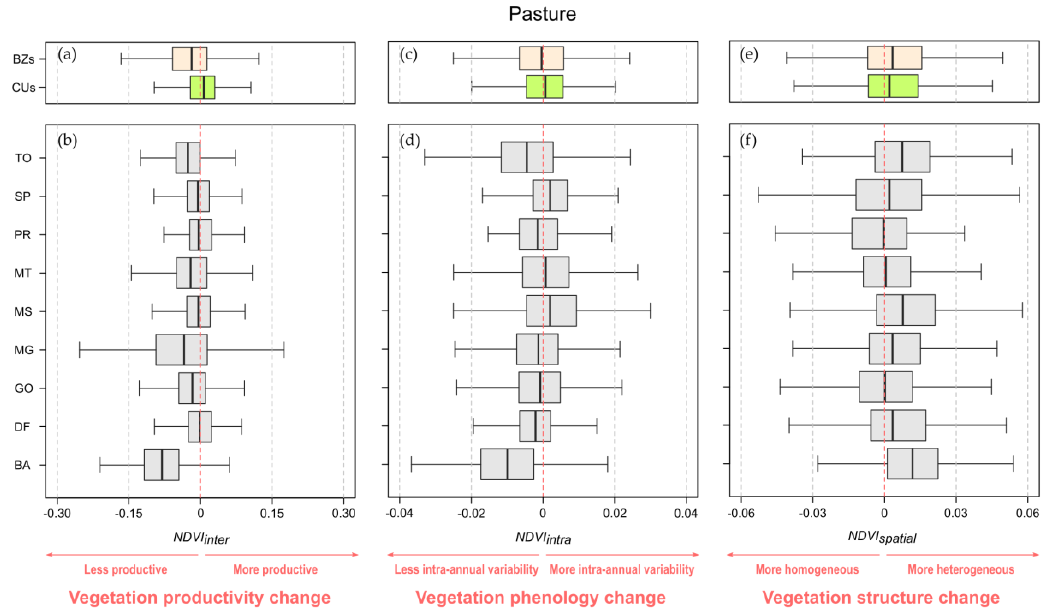
Figure E2. Boxplots of the landscape metrics’ values of the cells belonging to the ‘Pasture’ category : ( a ) 𝑁𝐷𝑉𝐼 𝑖𝑛𝑡𝑒𝑟 in the buffer zones (BZs) and conservation units (CUs); ( b ) 𝑁𝐷𝑉𝐼 𝑖𝑛𝑡𝑒𝑟 in each state; ( c ) 𝑁𝐷𝑉𝐼 𝑖𝑛𝑡𝑟𝑎 in the BZs and CUs; ( d ) 𝑁𝐷𝑉𝐼 𝑖𝑛𝑡𝑟𝑎 in each state; (e) 𝑁𝐷𝑉𝐼 𝑠𝑝𝑎𝑡𝑖𝑎𝑙 in the BZs and CUs; ( f ) 𝑁𝐷𝑉𝐼 𝑠𝑝𝑎𝑡𝑖𝑎𝑙 in each state. Number of 250 m resolution (6.25 ha) cells located inside the 61 conservation units = 1319 and in their buffer zones = 34,832. Number of cells in each Brazilian state with n > 0: Tocantins (TO, 436), São Paulo (SP, 3147), Paraná (PR, 45), Mato Grosso (MT, 5488), Mato Grosso do Sul (MS, 6666), Minas Gerais (MG, 13,444), Goiás (GO, 5233), Distrito Federal (DF, 673), Bahia (BA, 1019).